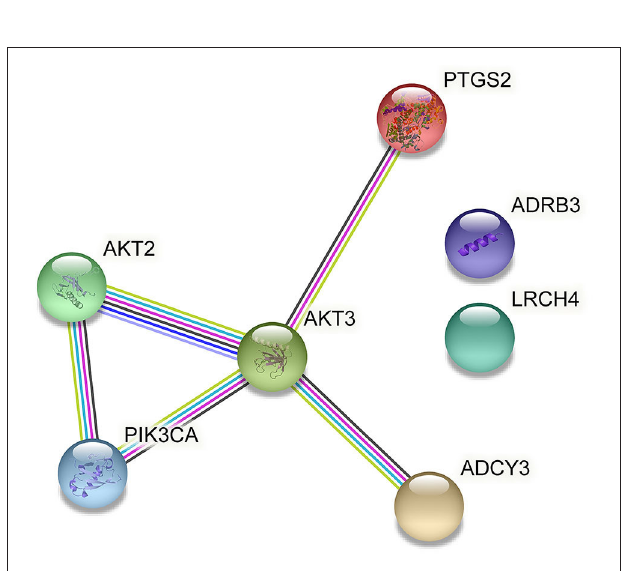
FIGURE 7 | Gene interactions enriched in Regulation of lipolysis in